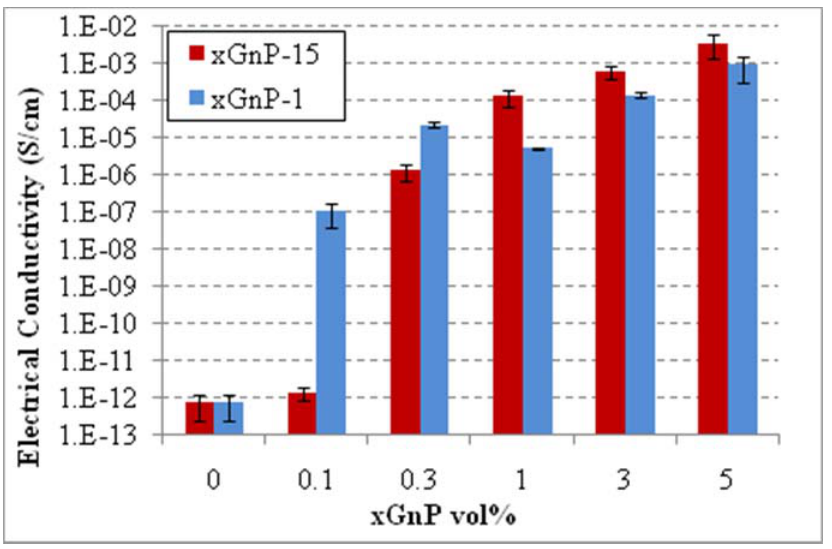
Figure 9. Percolation threshold and electrical conductivity of xGnP/PP nanocomposites made by coating (premixing) and compression molding.